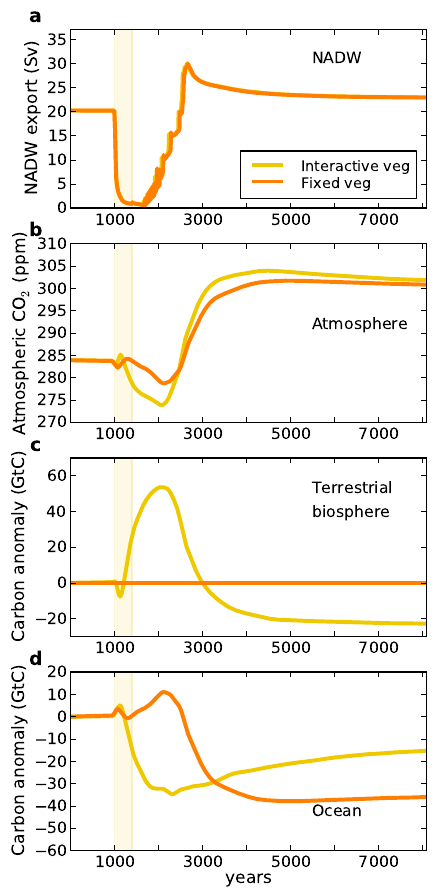
Fig. 9. Evolution of (a) NADW export (Sv) (maximum of the AMOC), (b) atmospheric CO 2 (ppm), (c) carbon content anomaly in the terrestrial biosphere (GtC) and (d) carbon content anomaly in the ocean (GtC) during two simulations with the Preindustrial (PI) background climate state. The fresh water flux of 0.5Sv for 400 yr is added into the North Atlantic. Yellow line is with interactive veg- etation (standard) and orange line with the vegetation fixed to its initial